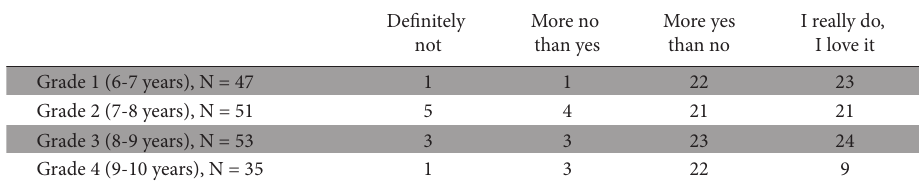
Figure 4: Distribution of pupils’ opinion on whether they like school (significance level of p � 0 . 01).